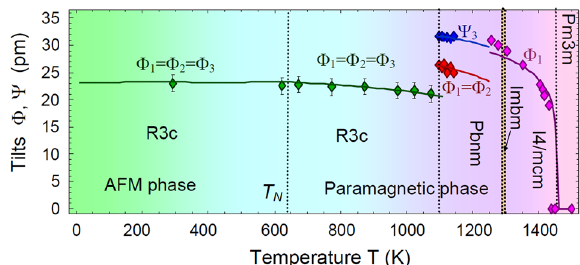
Fig. 4 Temperature dependence of oxygen displacement compo- nents for different phases of BiFeO 3 along with the fi tting ( solid curves ). Symbols of different phases ( R3c , Pbnm , Imbm , I4/mcm , and Pm3m ) are speci fi ed near the curves. Results for Pbnm phase are taken from, 58 tilt for virtual I4/mcm phase is from. 59 Fitting parameters are listed in the Table